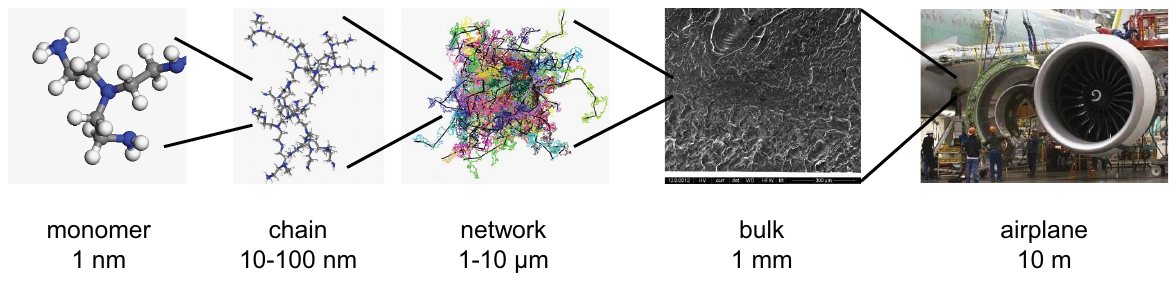
Figure 1. Hierarchical length scales for polymeric